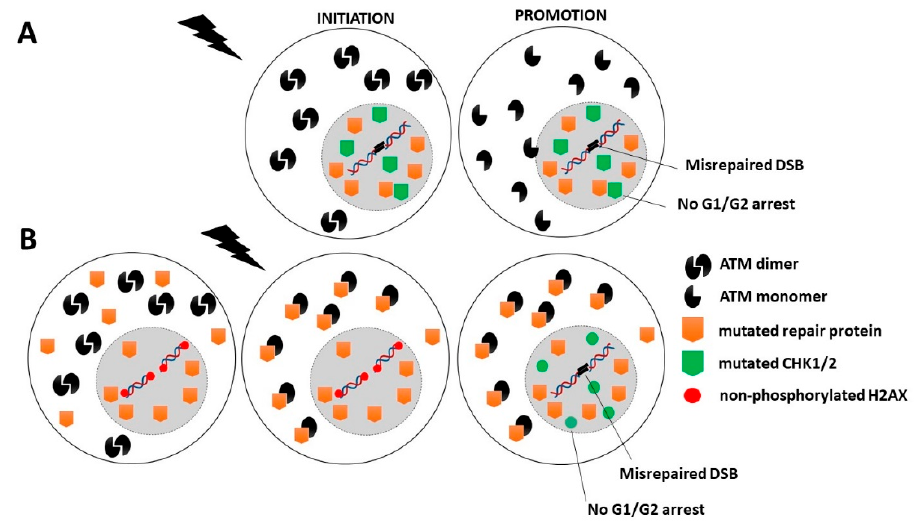
Figure 4. Schematic representation of the RIANS model in cells from Category 1 cancer syndromes.